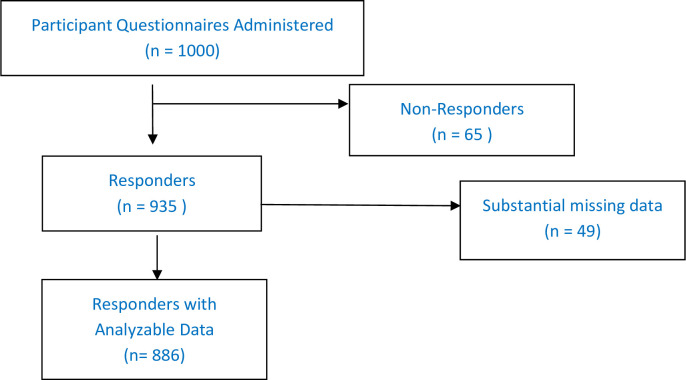
Flow diagram of participants recruitment.